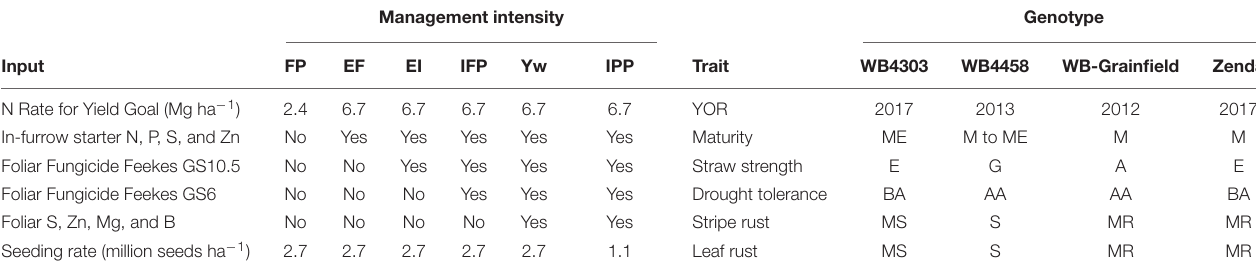
TABLE 1 | Description of the six management intensities and four winter wheat genotypes evaluated in the current